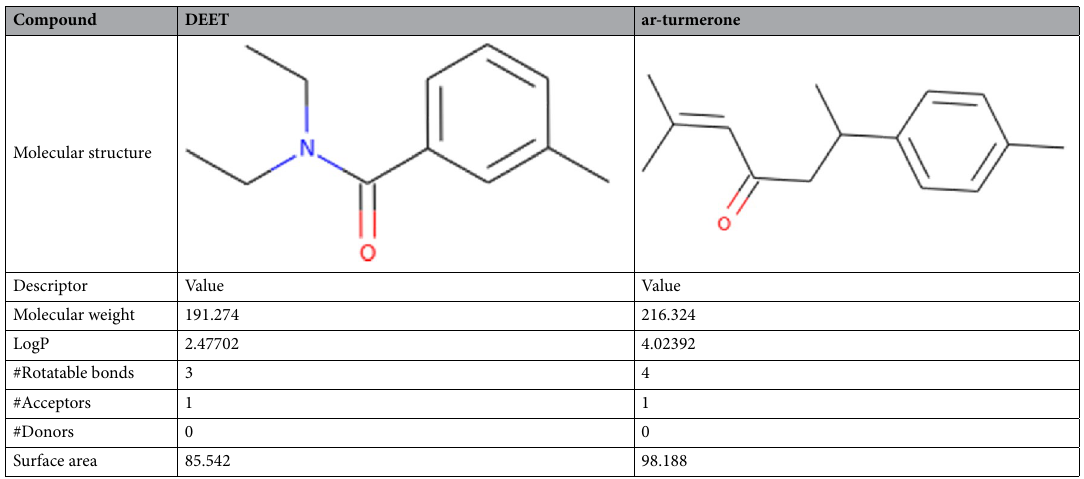
Table 2. Structural and chemical comparison of DEET and